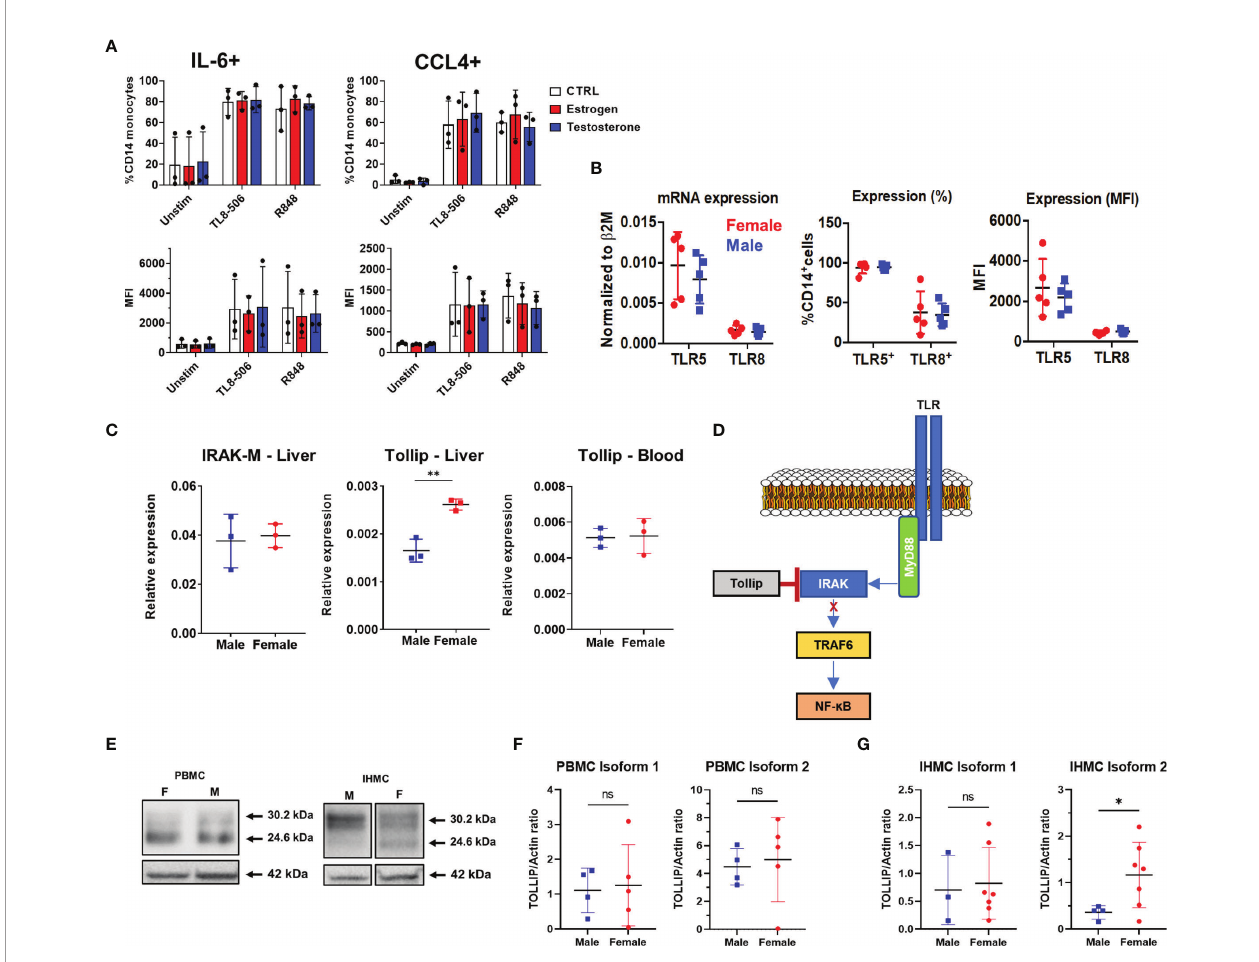
FIGURE 5 | Investigation of TLR expression and signaling. (A) Total HD PBMCs from exposed to estrogen or testosterone for 18 hours were stimulated with TLR8 agonists in the presence of Brefeldin A and IL-6 and CCL-4 production in CD14+ MN were measured by fl ow cytometry. Data displayed as percent of monocyte positive for each cytokine(top) or MFI (bottom) n=3 PBMC donors. (B) TLR expression in male and female liver monocytes. mRNA measured by qPCR (left) and protein expression measured by fl ow cytometry (right) n=5 males, 5 females. (C) Analysis of negative regulators of TLR signaling. TOLLIP expression was measured in both the liver (left) and blood (right). PBMC n=5 male, 5 female; IHMC n=3 male, 3 female. (D) Representation of TOLLIP ’ s intersection of the TLR signaling cascade to demonstrate the potential to in fl uence all TLRs. (E) Example western blot of TOLLIP protein (top) and Actin (bottom) in puri fi ed CD14+ monocytes. (F) TOLLIP isoform expression in blood monocytes does not show a signi fi cant relationship between sex and the expression of TOLLIP. (G) TOLLIP isoform 2 expression is elevated in female liver monocytes. Densitometry data was subject to outlier analysis with Grubb ’ s method. PBMC n=5 male, 5 female; IHMC n=4 males, 8 female, *p<0.05, **p<0.01, ns, non-signi fi cant, Mann-Whitney U tests. Figures depict mean +/-